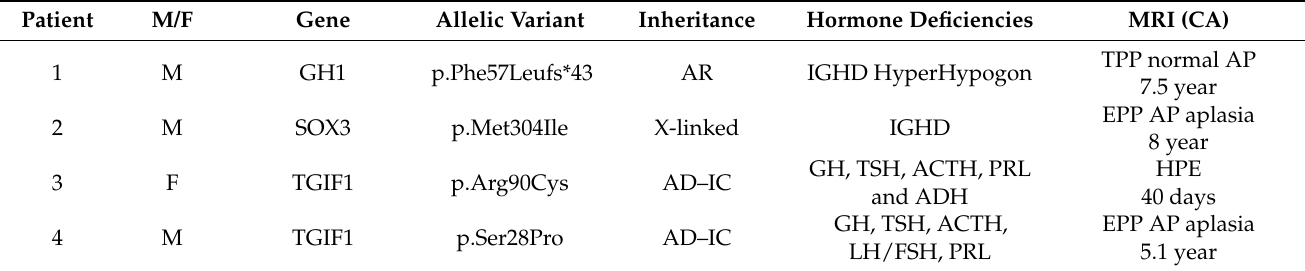
Table 2. Molecular diagnosis and patients’ clinical and image features.